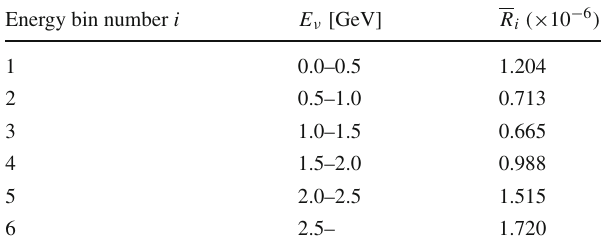
Table 2 Predictions for the far-to-near muon neutrino flux ratio as a function of neutrino energy, with the HARP measurement for π + pro- duction in primary hadronic interactions. The neutrino energy binning is also